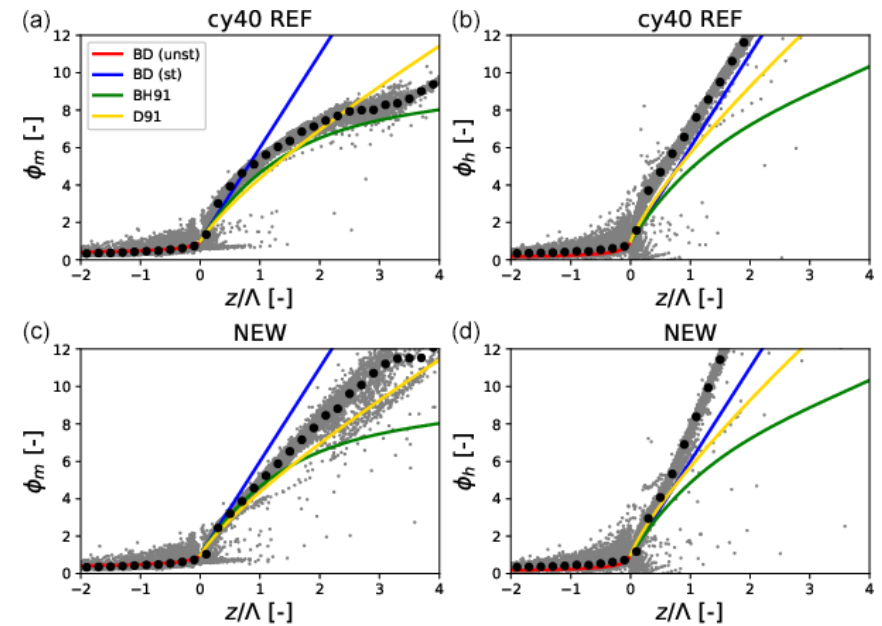
Figure 14. Dimensionless gradients of wind (a, c) and temperature (b, d) as a function of the local stability parameter z 1 year of SCM output (grey dots). Panels (a, b) and (c, d) show the results for cy40REF and cy40NEW, respectively. Black dots represent the mean of the modelled dimensionless gradients. Blue lines indicate 1 + 5 z lines the relations proposed by Duynkerke (1991). Explanations of the different formulations can be found in the text. For completeness, Dyer (1974) formulations for unstable conditions are plotted (red line).